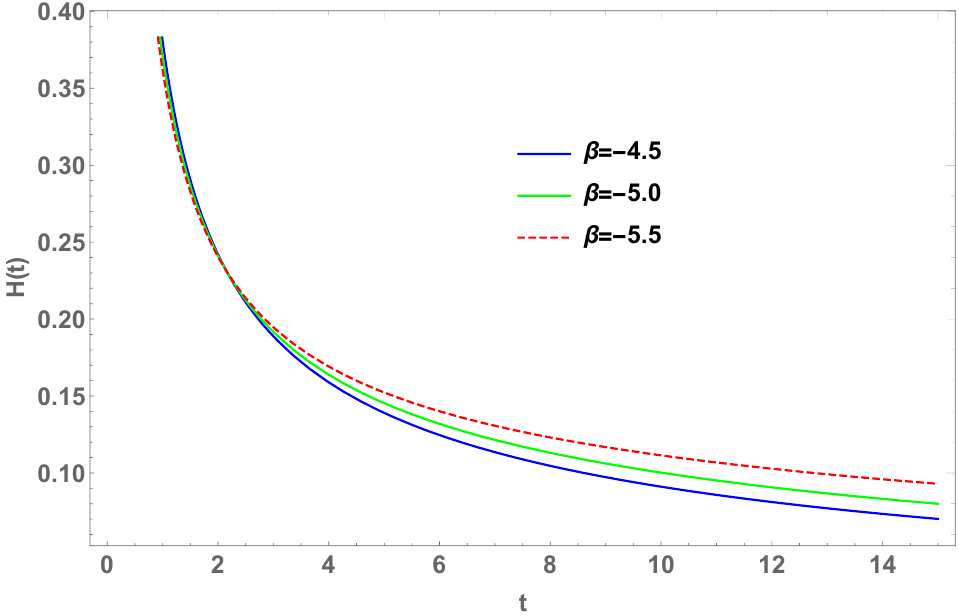
Figure 2. Behaviour of the Hubble parameter ( H ) with respect to cosmic time t for different values of β with α = − 1.5, b =